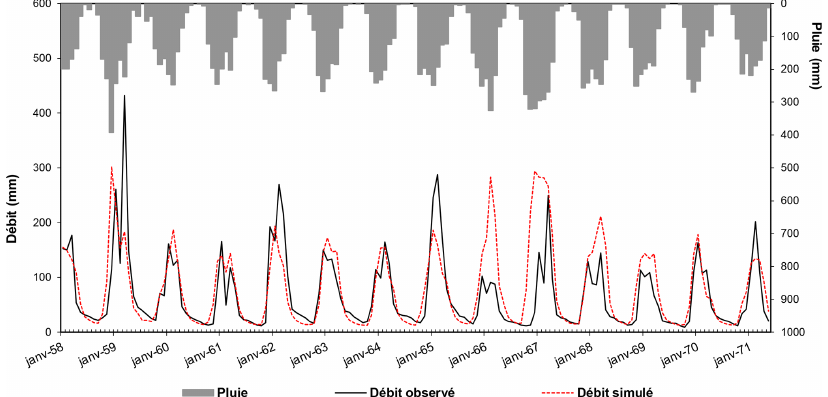
Figure 2. Modélisation des débits mensuels de la Betsiboka à Ambodiroka à partir du modèle hydrologique CR2M, et débits mesurés de 1958 à